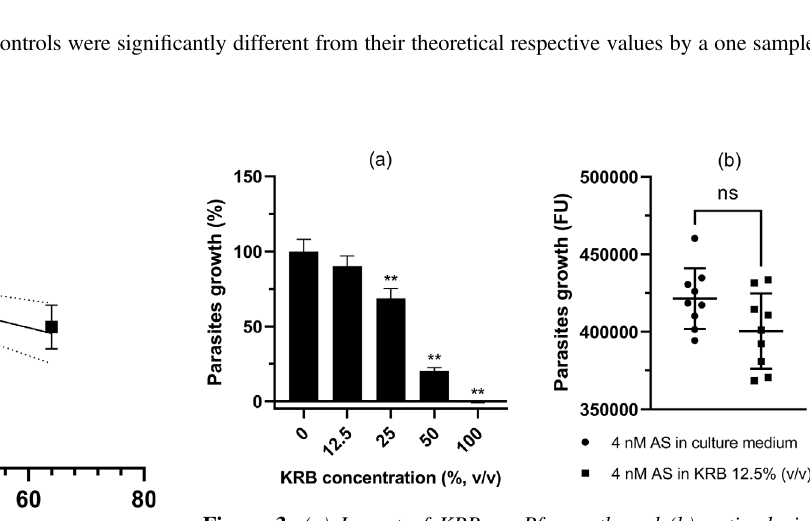
Figure 3. (a) Impact of KRB on Pf growth and (b) antimalarial activity of artesunate at 4 nM prepared in culture medium or 12.5% KRB in culture medium for the semi-quantitative test. KRB concentrations above 12.5% (v/v) signi fi cantly reduced parasites growth. All samples containing KRB were therefore diluted into culture medium before use to limit its impact. Each concentration was tested in triplicate in two independent assays. Data are presented as the mean ± SD ( n = 6). There was no statistical difference between the antimalarial activities of 4 nM artesunate solutions prepared in culture medium and 12.5% (v/v) KRB. Each sample was tested in triplicate in three independent assays. Data are presented as mean ± SD ( n = 9). KRB = Krebs ringer buffer; AS = artesunate; FU = fl uorescence unit; ns: non-signi fi cant. Statistical analyses were performed with GraphPad Prism software, Mann – Whitney test, a = 5%, p -value (**) =